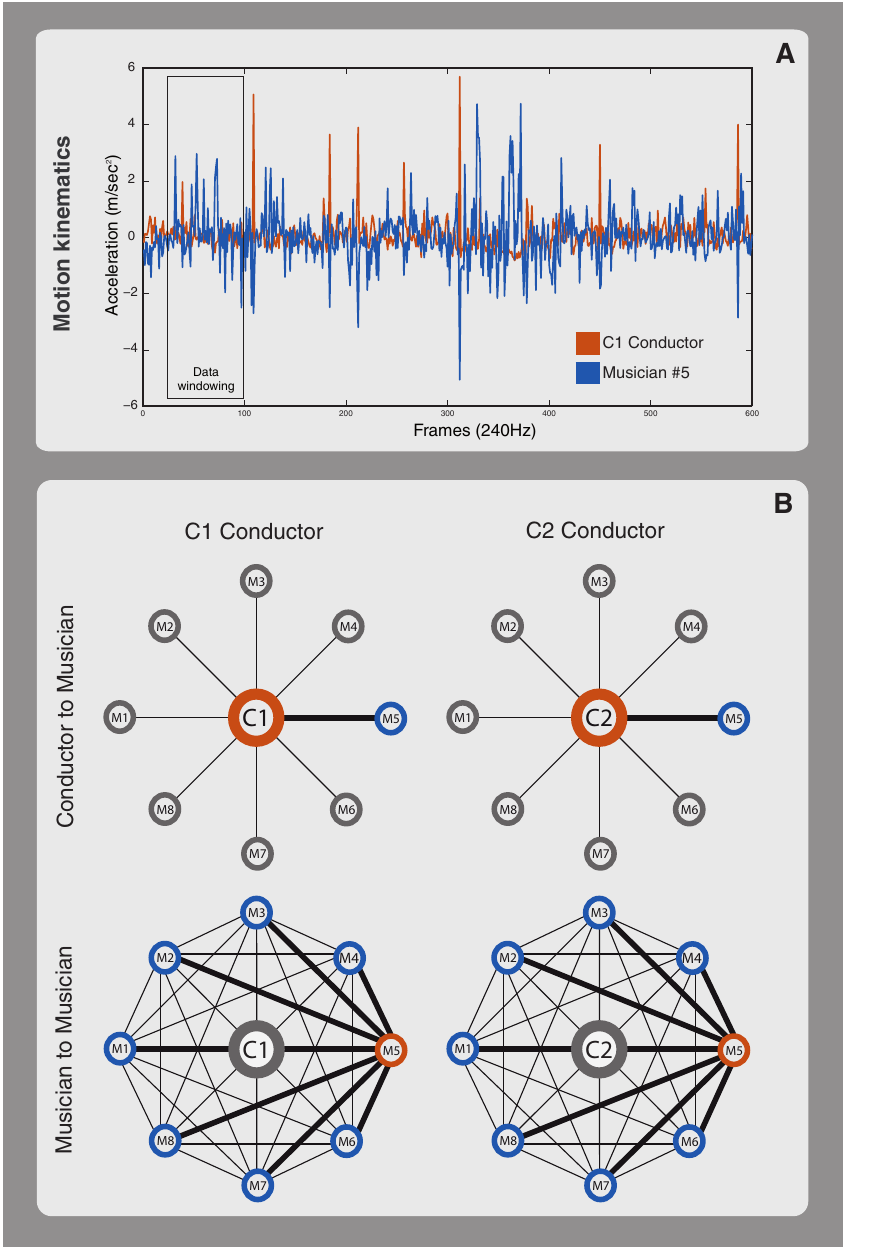
Figure 1. Experimental design. For each piece of music, the time is divided into overlapping windows (panel A show acceleration profiles of C1 conductor in orange and Violin number 5 in blue). The pairwise driving forces between the conductor (orange circle) and each player (blue circle) are computed. The performances are evaluated using conductor-player pairs. Subsequently, compute the pairwise driving forces between players. The summed value of forces between each player (in orange) towards all other musicians (blue circle), excluding the contribution of the conductor (here in grey), forms the interaction strength for that musician (Panel B).